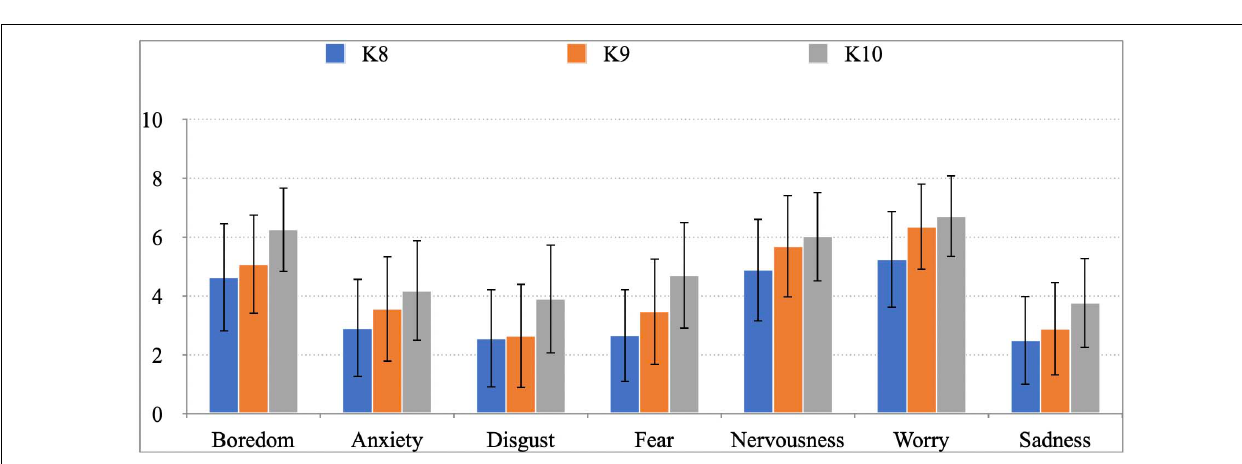
FIGURE 2 | Mean frequency of negative emotions experienced by secondary pupils when learning Physics and Chemistry depending on the